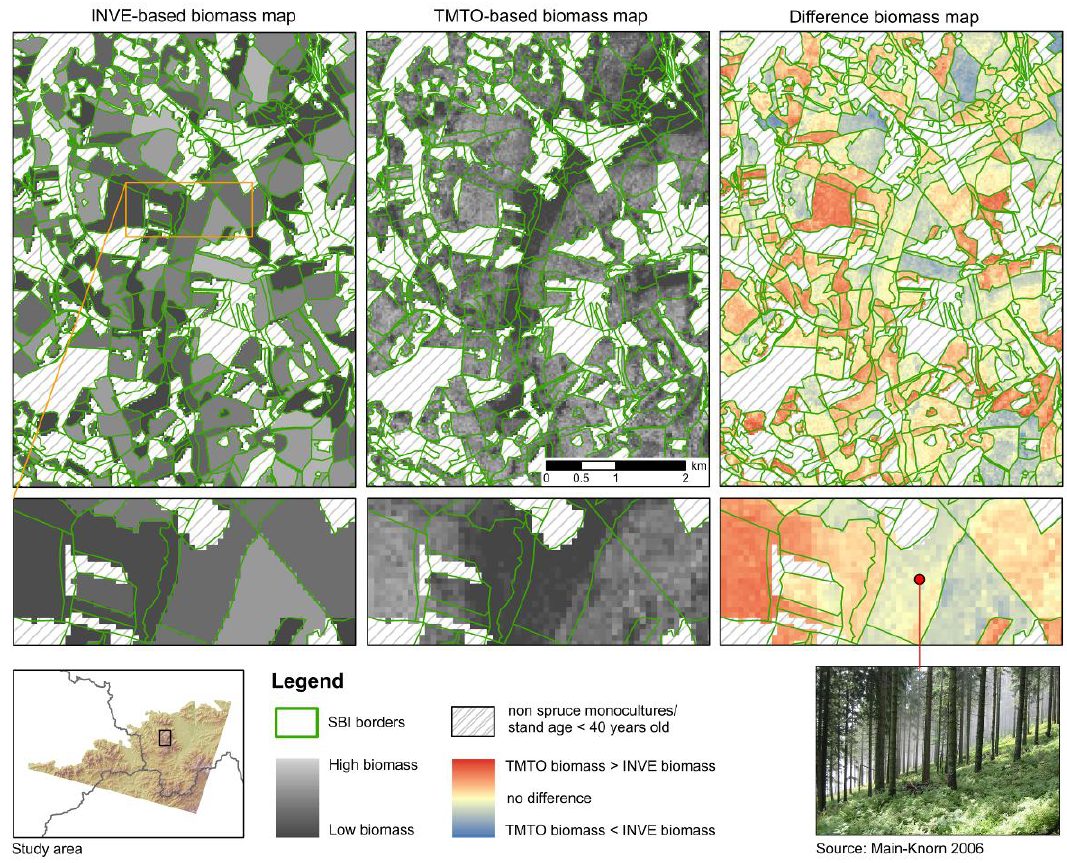
Figure 6. Single model-based biomass maps and the difference biomass